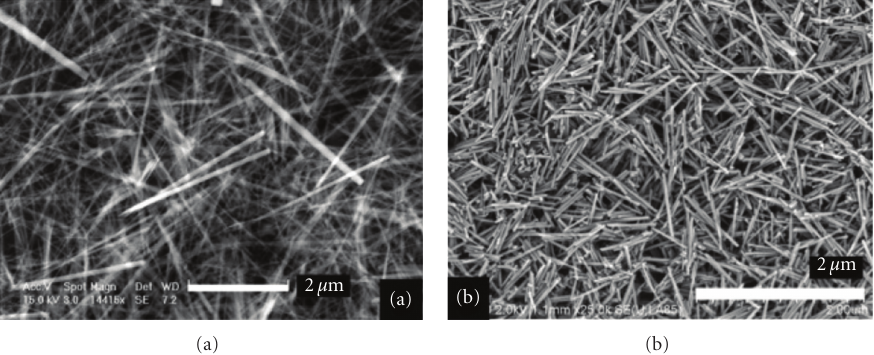
Figure 1: SEM images of (a) fluorapatite nanorods prepared by direct precipitation from solution and (b) enamel crystals isolated from the maturation stage of rat incisor enamel [8]. (Reproduced with permission from the American Chemical